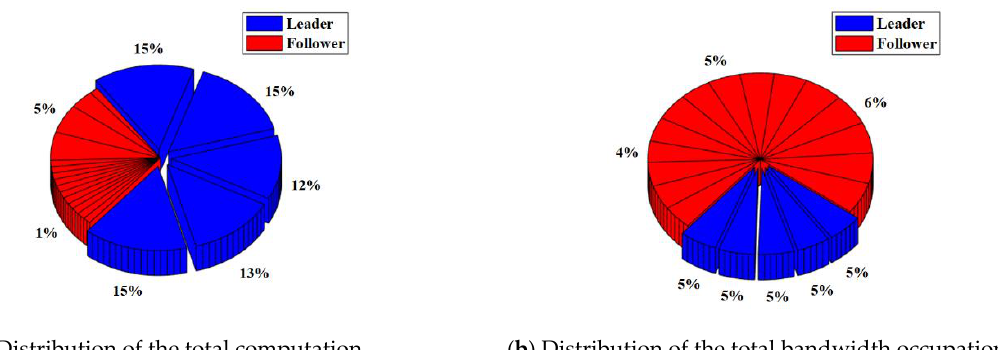
( b ) Distribution of the total bandwidth occupation Figure 12. Resource occupation of the RIPPLE algorithm with no malicious nodes. Compared with the satellite cluster without malicious nodes, the total computation and the total bandwidth occupation of the satellite cluster with malicious nodes are simi- lar, which are 3249 K and 656 Kb, respectively. The negotiation can be successfully com- pleted through the RIPPLE algorithm. Moreover, the computation used by the leader is